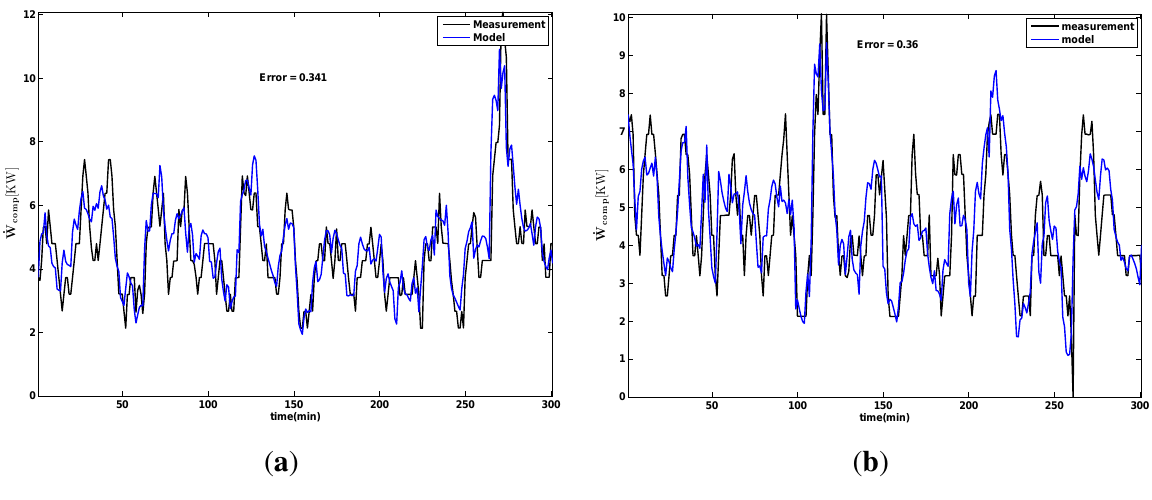
Figure 9. Power consumption estimation of the compressor bank after system